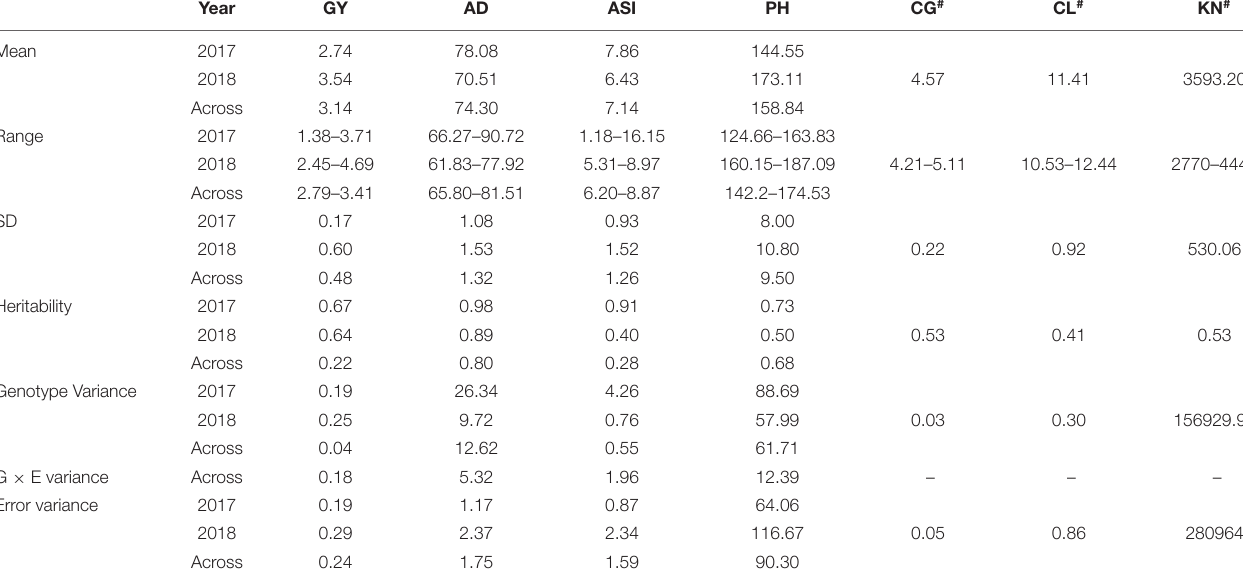
TABLE 1 | Descriptive statistics of the association mapping panel evaluated under salinity stress. Year GY AD ASI PH CG # CL # KN #